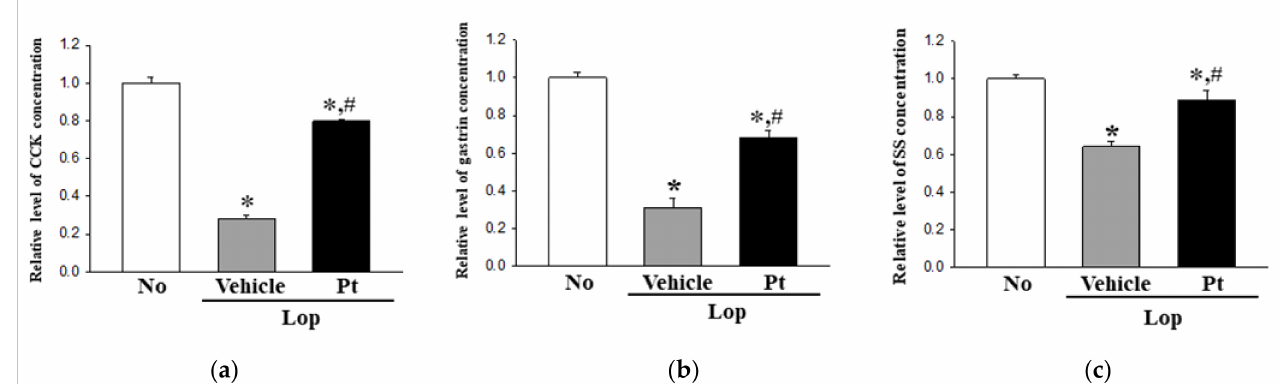
Figure 5. Concentrations of three GI hormones after administration of Pt. After preparation of the mid-colon homogenate, the concentrations of ( a ) CCK, ( b ) gastrin, and ( c ) SS were measured with an enzyme-linked immunosorbent assay (ELISA). The above kits for CCK, gastrin, and SS can detect up to 0.1–1000 pg/mL, 0.312–20 pg/mL, and 4.7–300 pg/mL. A total of 4–6 SD rats were used in the preparation of tissue homogenate, and hormone levels were assayed in duplicate in each sample. The data are reported as the mean ± SD. *, p < 0.05 compared to the non-treated (No) group. #, p < 0.05 compared to the Lop+Vehicle-treated group. Abbreviations: Lop, loperamide; Pt, phlorotannins; GI, gastrointestinal; CCK, cholecystokinin; SS,